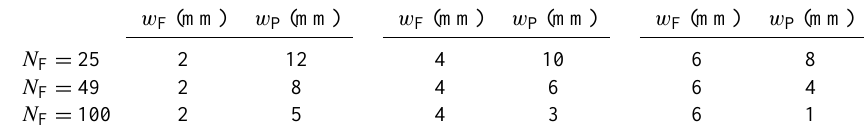
Table 3. Fin thickness and inter-fin distance for different fin numbers.